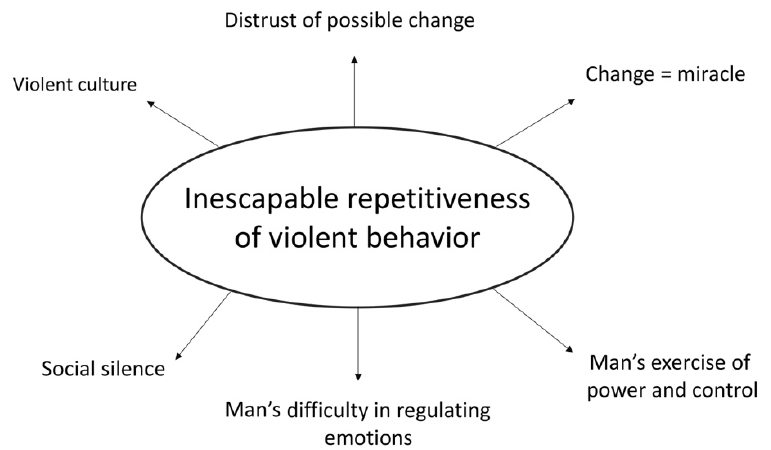
Figure 2. Core category and semeiotic network “Inescapable repetitiveness of violent behavior”.